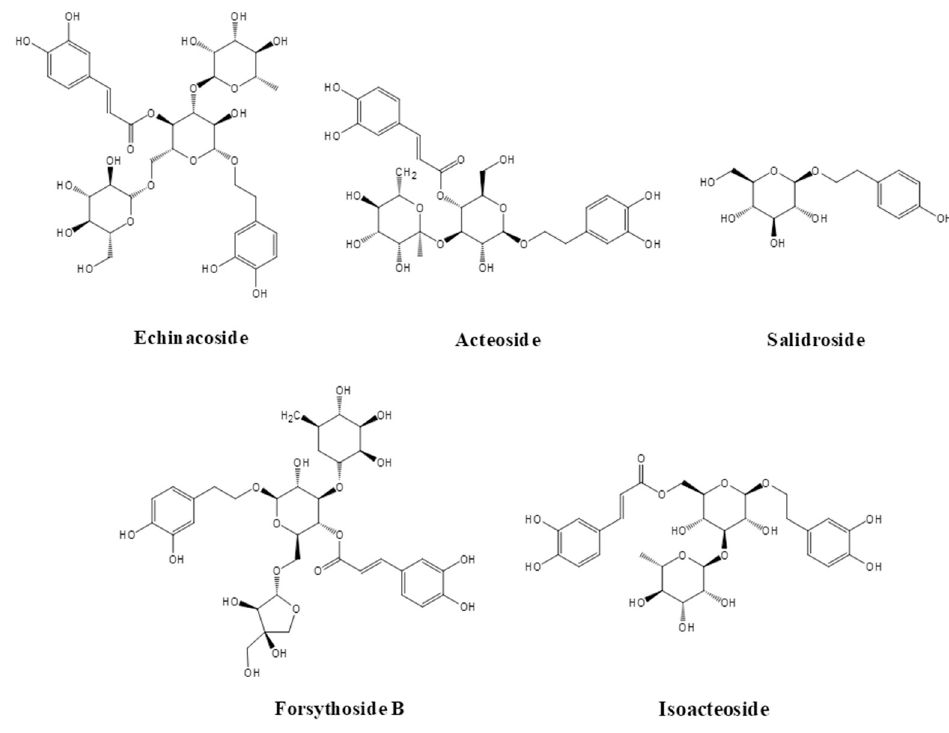
Figure 1. The molecular structures of several typical PhGs.